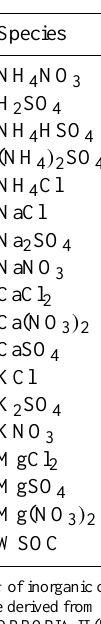
Table 2. The hygroscopicity parameter κ of relevant particle com-